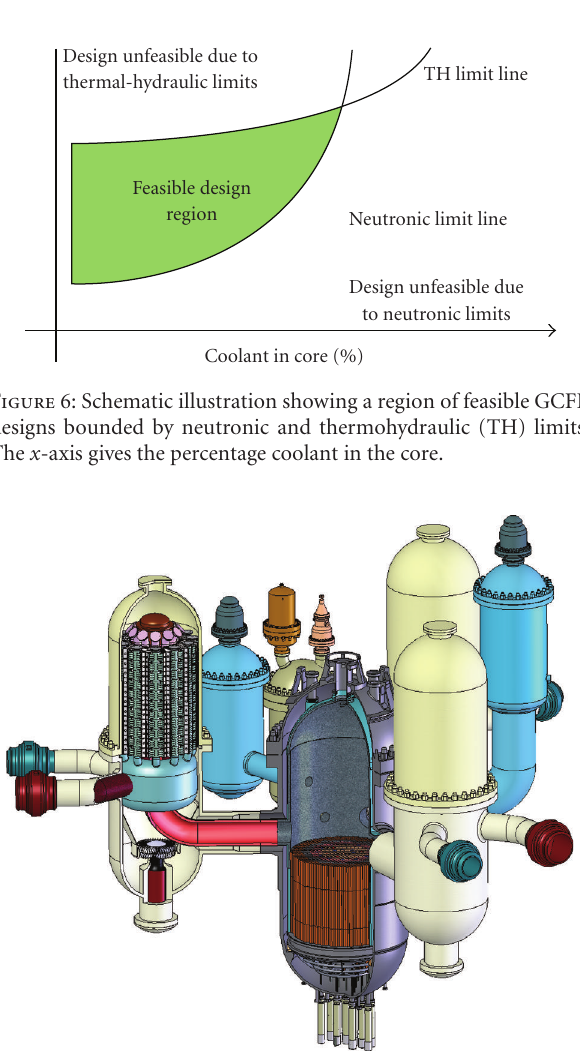
Figure 7: A cross-cut through a 2400 MWth Gen IV GCFR plant with indirect cycle operation. The large structures contain the intermediate heat exchangers. The elevated structure on the right is the decay heat exchanger. The entire system would be built into a tight-fitting secondary close containment. Image provided by